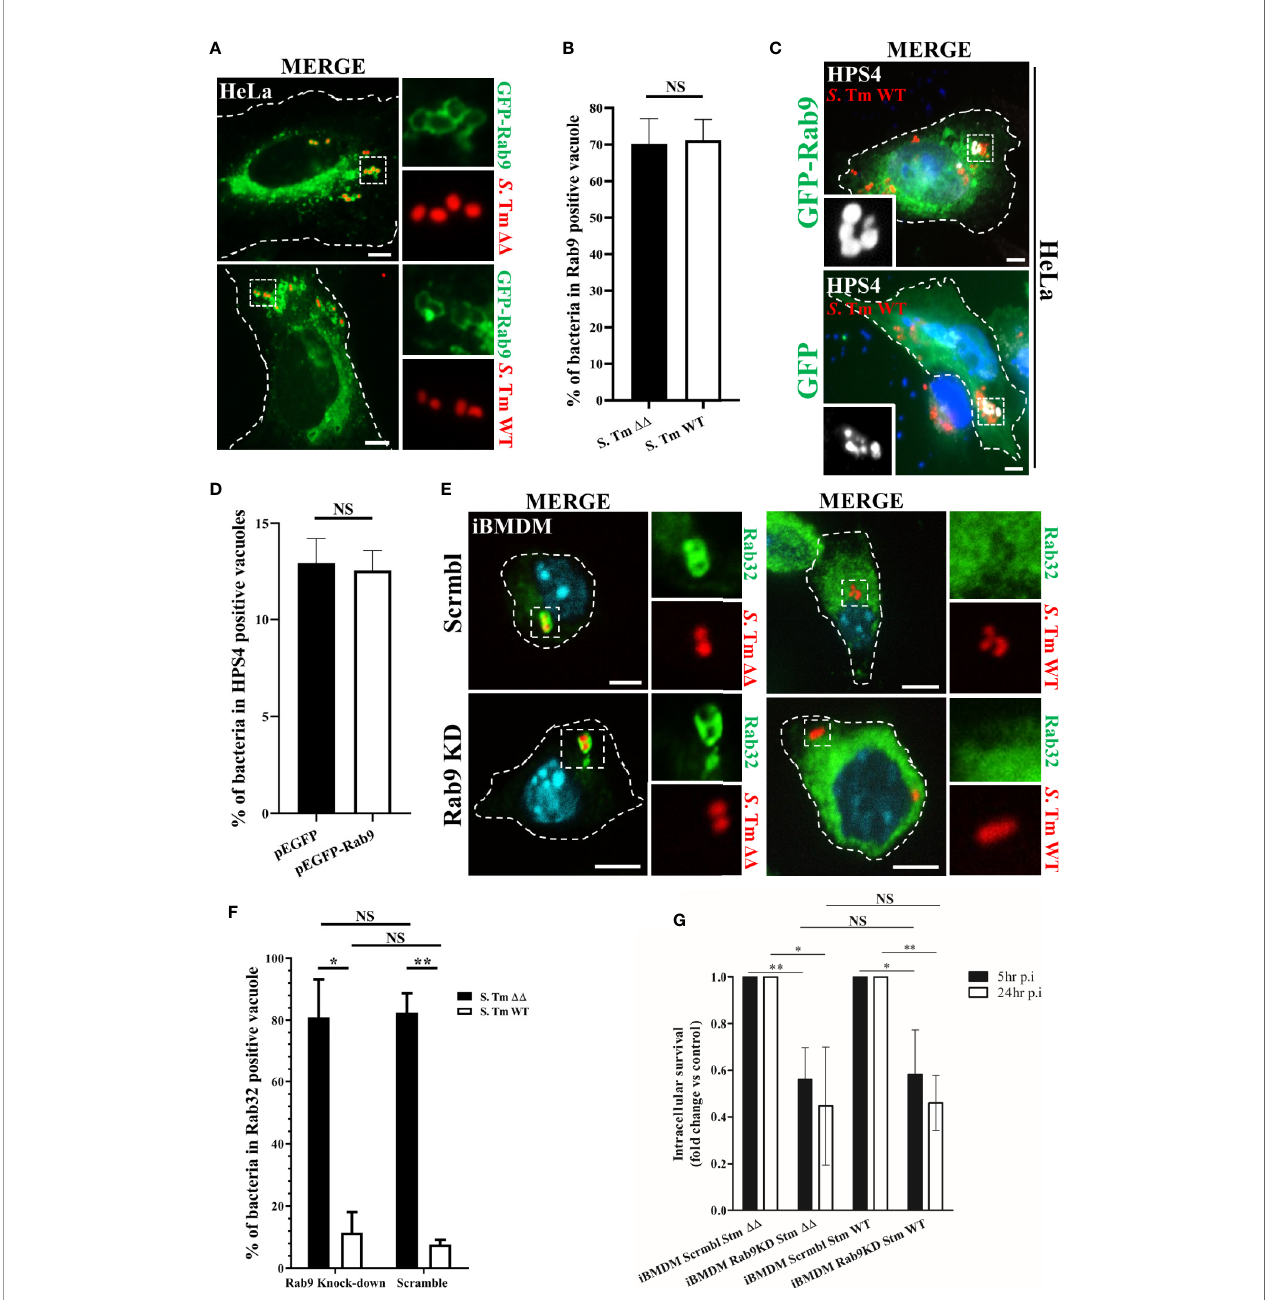
FIGURE 2 | Rab9 does not regulate Rab32 recruitment to the Salmonella -containing vacuoles (SCV) and its function is not required for Rab32/BLOC-3 dependent killing. (A) GFP-Rab9 transfected HeLa cells were infected with mCherry S . Typhimurium D gtgE D sopD2 ( DD ) or WT for 2.5 h, fi xed and images were acquired using fl uorescent microscopy. (B) The percentage of S . Typhimurium in Rab9-positive vacuoles at 2.5 h post-infection is shown with ± standard-deviation of three independent experiments. (C) HeLa cells transfected with either GFP or GFP-Rab9 were infected with mCherry S . Typhimurium WT for 2.5 h. Cells were then fi xed, stained with monoclonal anti-HPS4 (gray) antibody and analyzed by fl uorescence microscopy. (D) The percentage of S . Typhimurium in HPS4-positive vacuoles at 2.5 h post-infection is shown with ± standard-deviation of three independent experiments. (E) iBMDM cells knocked down for Rab9 (Rab9 KD) and control (Scrmbl) were infected with mCherry S . Typhimurium D gtgE D sopD2 or WT for 2.5 h, fi xed and stained with anti-Rab32 (green). Images were acquired using fl uorescent microscopy (F) The percentage of S . Typhimurium in Rab32-positive vacuoles is shown with the ± standard-deviation from three independent experiment. (G) iBMDM cells depleted for Rab9 (Rab9 KD) and control cells (Scrmbl) were infected with S . Typhimurium D gtgE D sopD2 or WT, lysed at the indicated time points and colony-forming units were calculated. Values are presented as fold change compared to the initially internalized (1.5 hpi). Error bars indicate standard-deviation of fi ve independent experiments. For the non-normalized values see Figure S2 . (Student ’ s t test; *p < 0.05, **p < 0.01) S . Tm, Salmonella Typhimurium; KD, Knock-down; CFUs, Colony-forming units; Scale bar: 5 m m; NS, non statistically